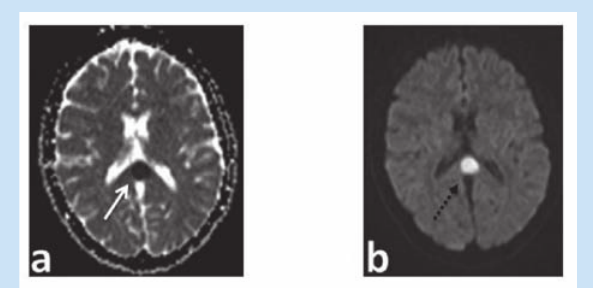
Fig. 2. Diffusion-weighted MRI sequences reveal a focal lesion with restricted diffusion. (a) ADC map demonstrates reduced signal within the splenial lesion (arrow). (b) Corresponding hyperintensity on the B- 1000 image confirms restricted diffusion (~~>).